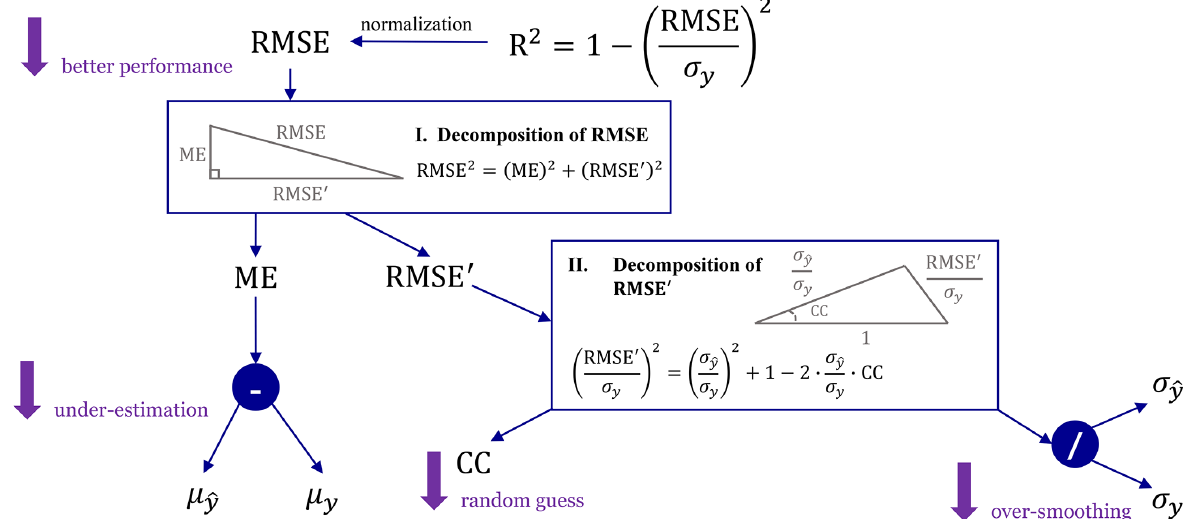
Figure 9. Decomposition of RMSE and R 2 where two boxes represent two steps of the decomposition analysis. Coloured arrows indicate the computation flow for error metrics and coloured circles represent the computation operators where “–” denotes µ ˆ y − µ y and “/” denotes µ ˆ y /µ y . See Table 2 for detailed definitions of